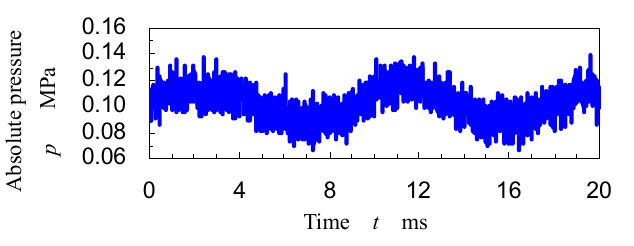
Fig. 6 Pressure fluctuation at the